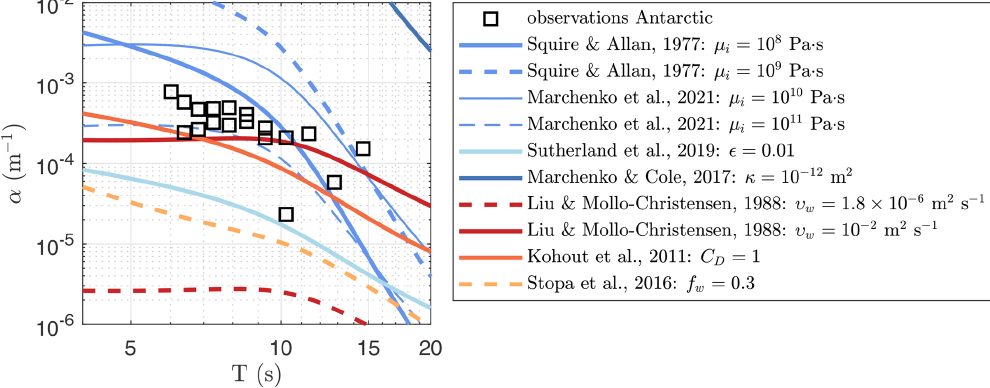
Figure 6. Same as Fig. 5, except for the Antarctic experiment. Models have not been fitted to the data. Note, limited observations are available for the Antarctic experiment, and results should be interpreted by their order of magnitude rather than fine-scale